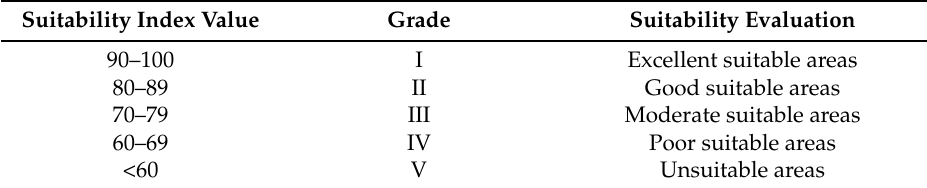
Table 11. RBF suitability